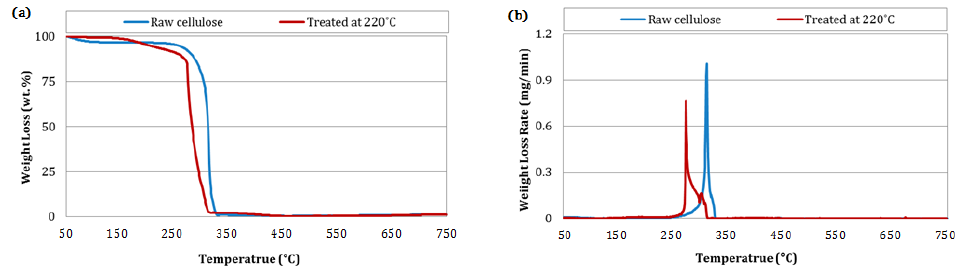
Figure 5. TG and DTG profiles of cellulose and its biochar at 220°C; ( a ) TG profile; and ( b ) DTG profile.